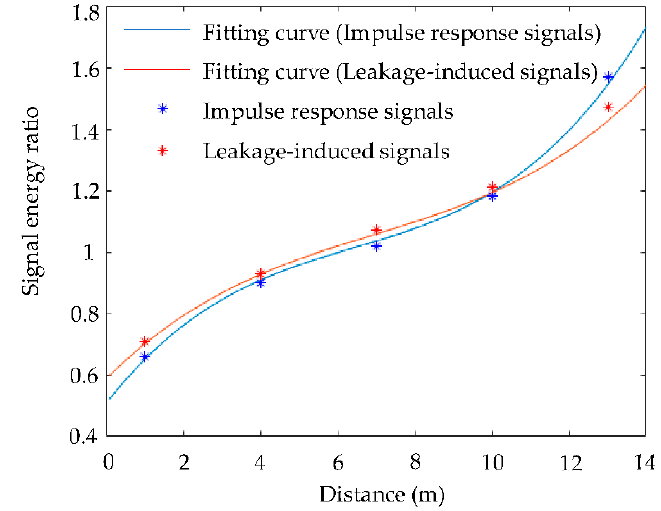
Figure 12. Fitting curves of the signal energy ratios of the AE signals measured by the two sensors.